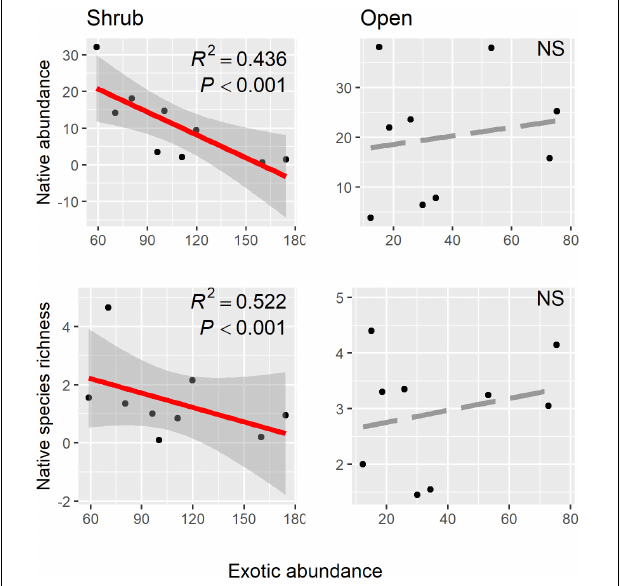
FIGURE 3 | Native abundance and native species richness (all native species combined) plotted against exotic abundance (all exotic species combined) in shrub and open microsites. Red regression lines ( ± 95% CI) indicate significant native-exotic relationships.